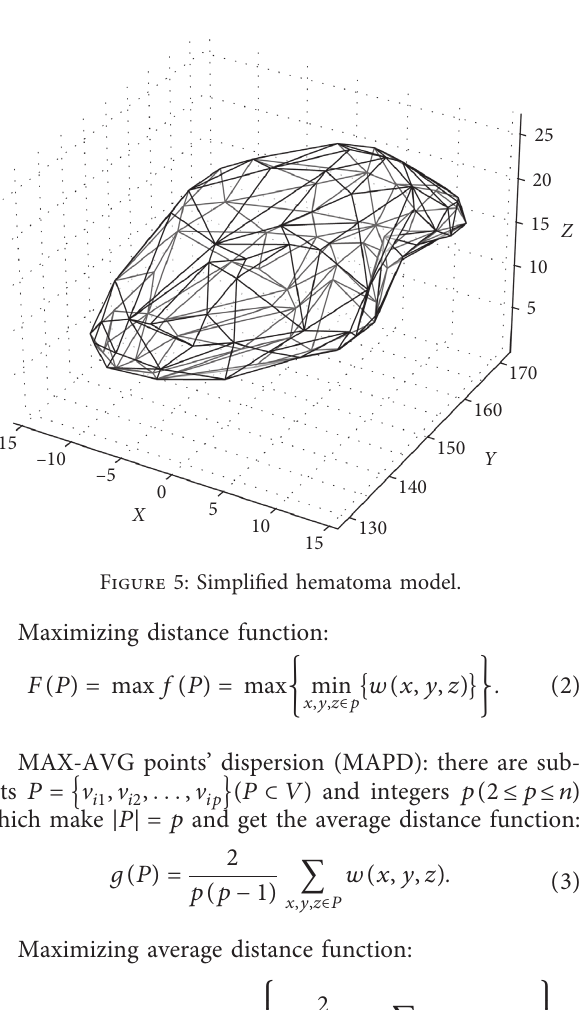
Figure 4: Before simplification hematoma model.